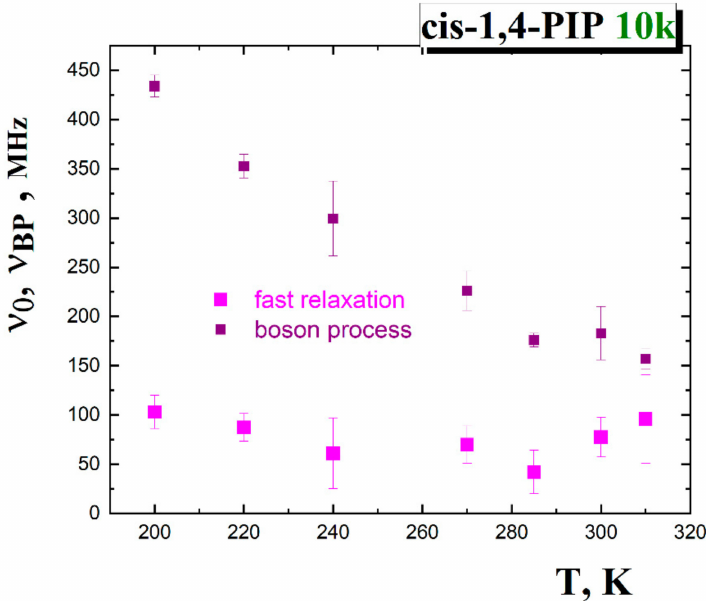
Figure 9. Temperature dependences of the fast motion and the boson process frequencies in cis